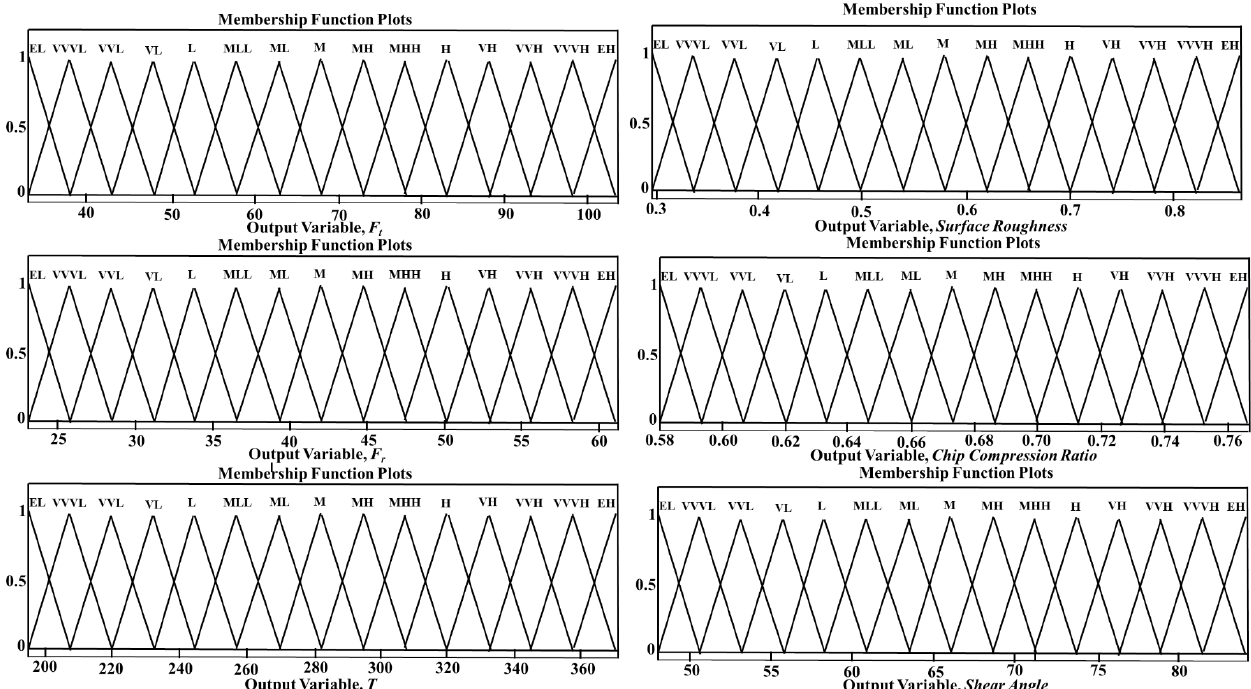
Figure 3. Output variables with associated membership functions used in the simulation of UVAT.